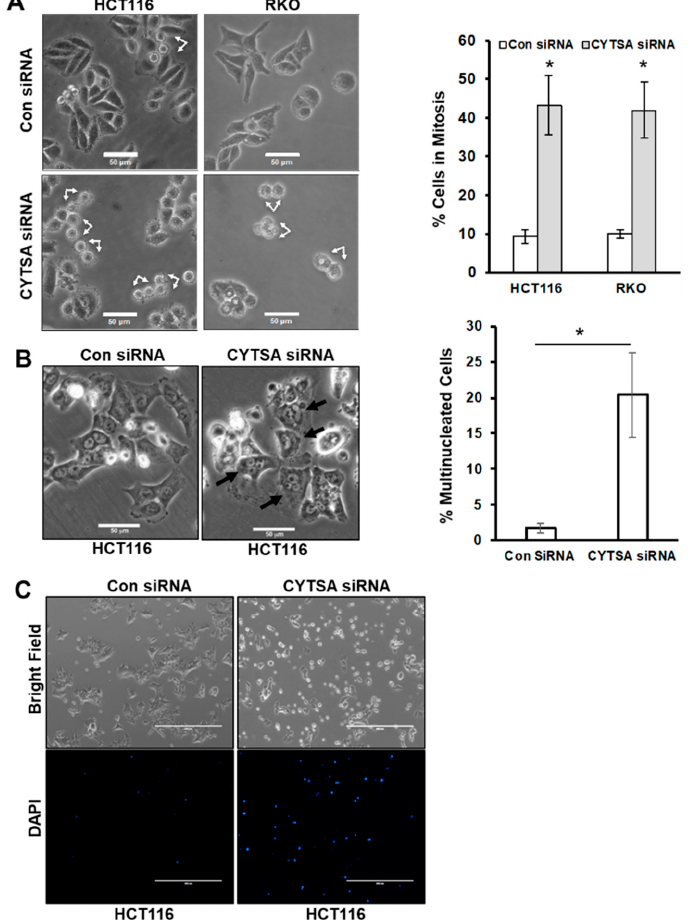
Figure 2. Depletion of CYTSA results in cell division defects in CRC. ( A ) Bright ‐ field images are shown of HCT116 or RKO cells treated with Con siRNA and CYTSA siRNA at 48 h after siRNA transfection (left panel). Post ‐ mitotic doublet cells are indicated by arrows. Scale bar = 50 μ m. Images from Con siRNA or CYTSA siRNA transfected sets were manually counted to determine the per ‐ centage of mitotic or post ‐ mitotic doublet cells. Results are plotted for HCT116 and RKO cells from at least three experimental sets (right panel). * p ‐ value < 0.05. ( B ) Bright ‐ field images of HCT116 cells were obtained 4 days after being transfected with Con siRNA or CYTSA siRNA (left panels). Mul ‐ tinucleated cells are designated with black arrows for the CYTSA siRNA set. Scale bar = 50 μ m. ( C ) HCT116 cells were transfected with either Con siRNA (left panels) or CYTSA siRNA (right panels). Cells were grown for 72 h; DAPI was added to the media, and images were taken with a 4× objective. Bright ‐ field (top panels) or fluorescence images for DAPI (lower panels) are shown. CYTSA siRNA ‐ treated cells have a significantly higher number of dead and dying cells that take up DAPI than do Con siRNA ‐ treated cells.